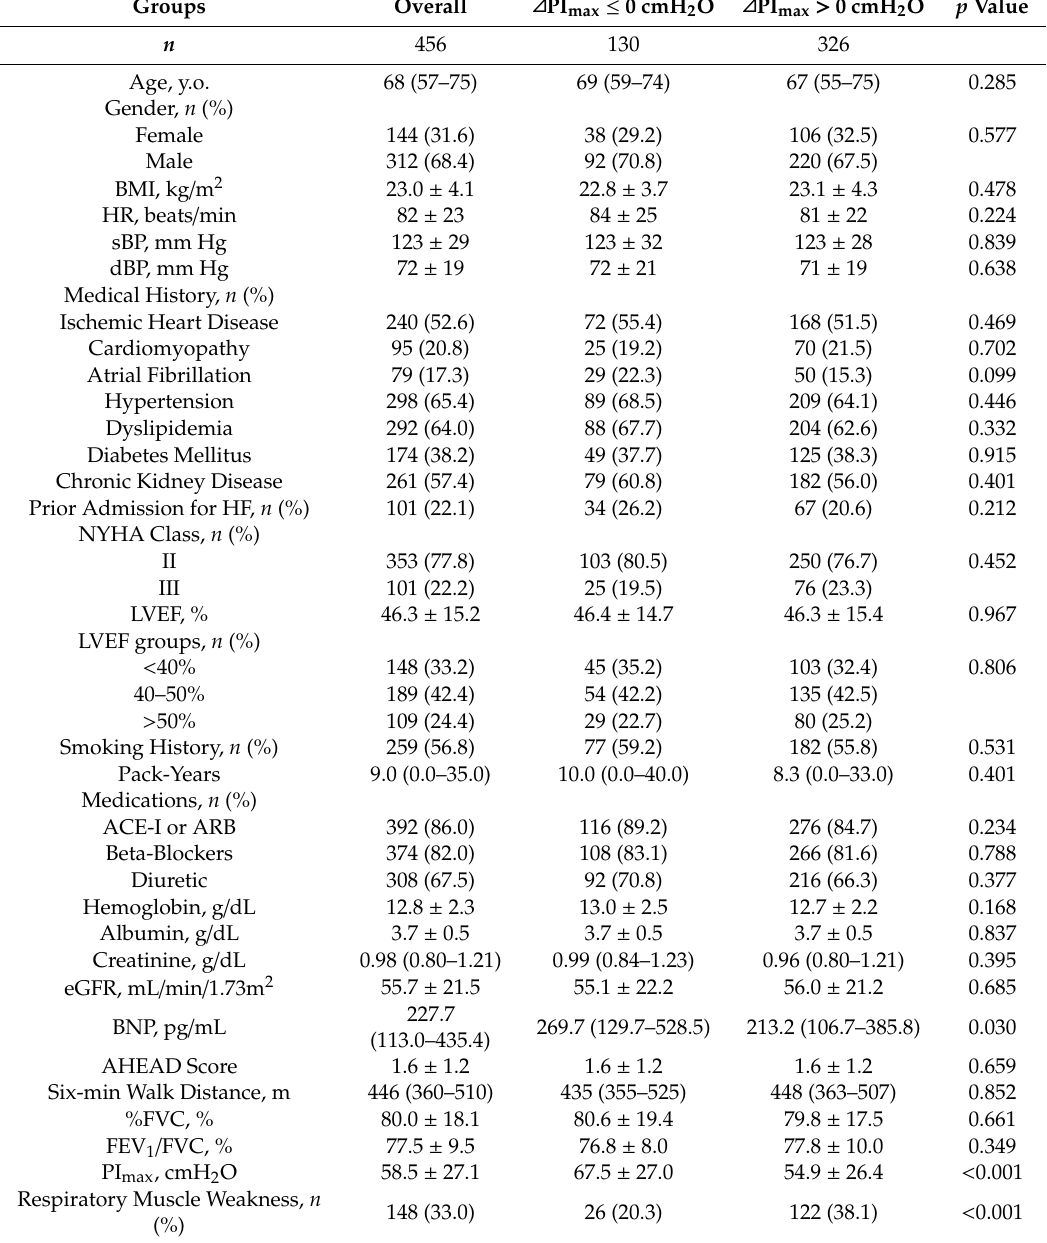
Table 1. Baseline patient characteristics in the two groups based on change in PI